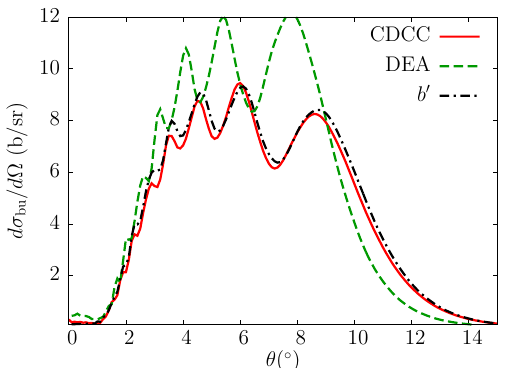
Figure 7: Angular distribution for the breakup of 15 C on Pb at 20 MeV / nucleon. Dynamical eikonal calculations and its low-energy correction are compared to fully quantal CDCC results [ 30 ] . The simple low-energy correction enables to reproduce the correct magnitude and oscillatory pattern of the cross section. Figure adapted from Ref. [ 30 ] . Copyright (2014) by the American Physical